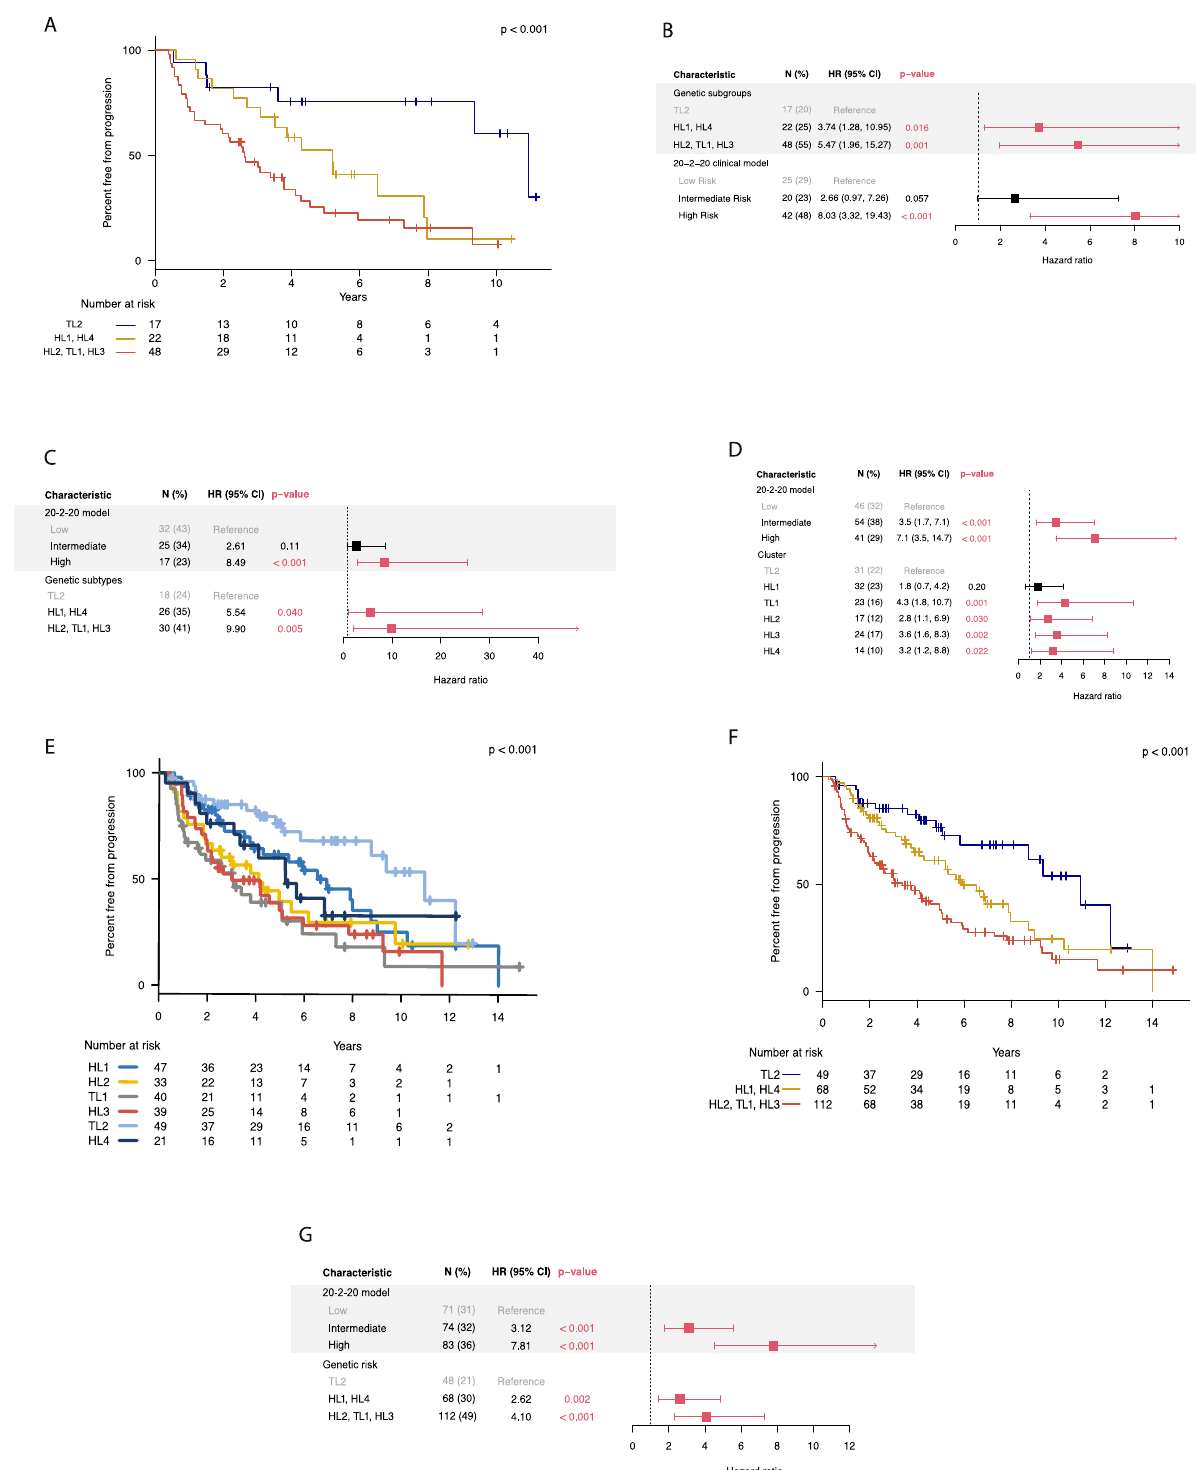
Also, MYC expression was higher in the hyperdiploid subgroups of a higher frequency of MYC alterations in hyperdiploid MM patients 22 . The key Cyclin D genes, CCND1 and CCND2 , were highly expressed in TL2 and TL1 , respectively. CCND1 and guish between MM patients hyperdiploid tumor samples 23